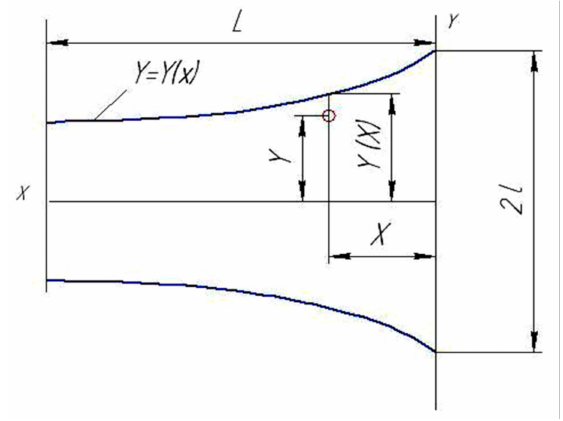
Figure 2. Design diagram of the cross-section of the operating